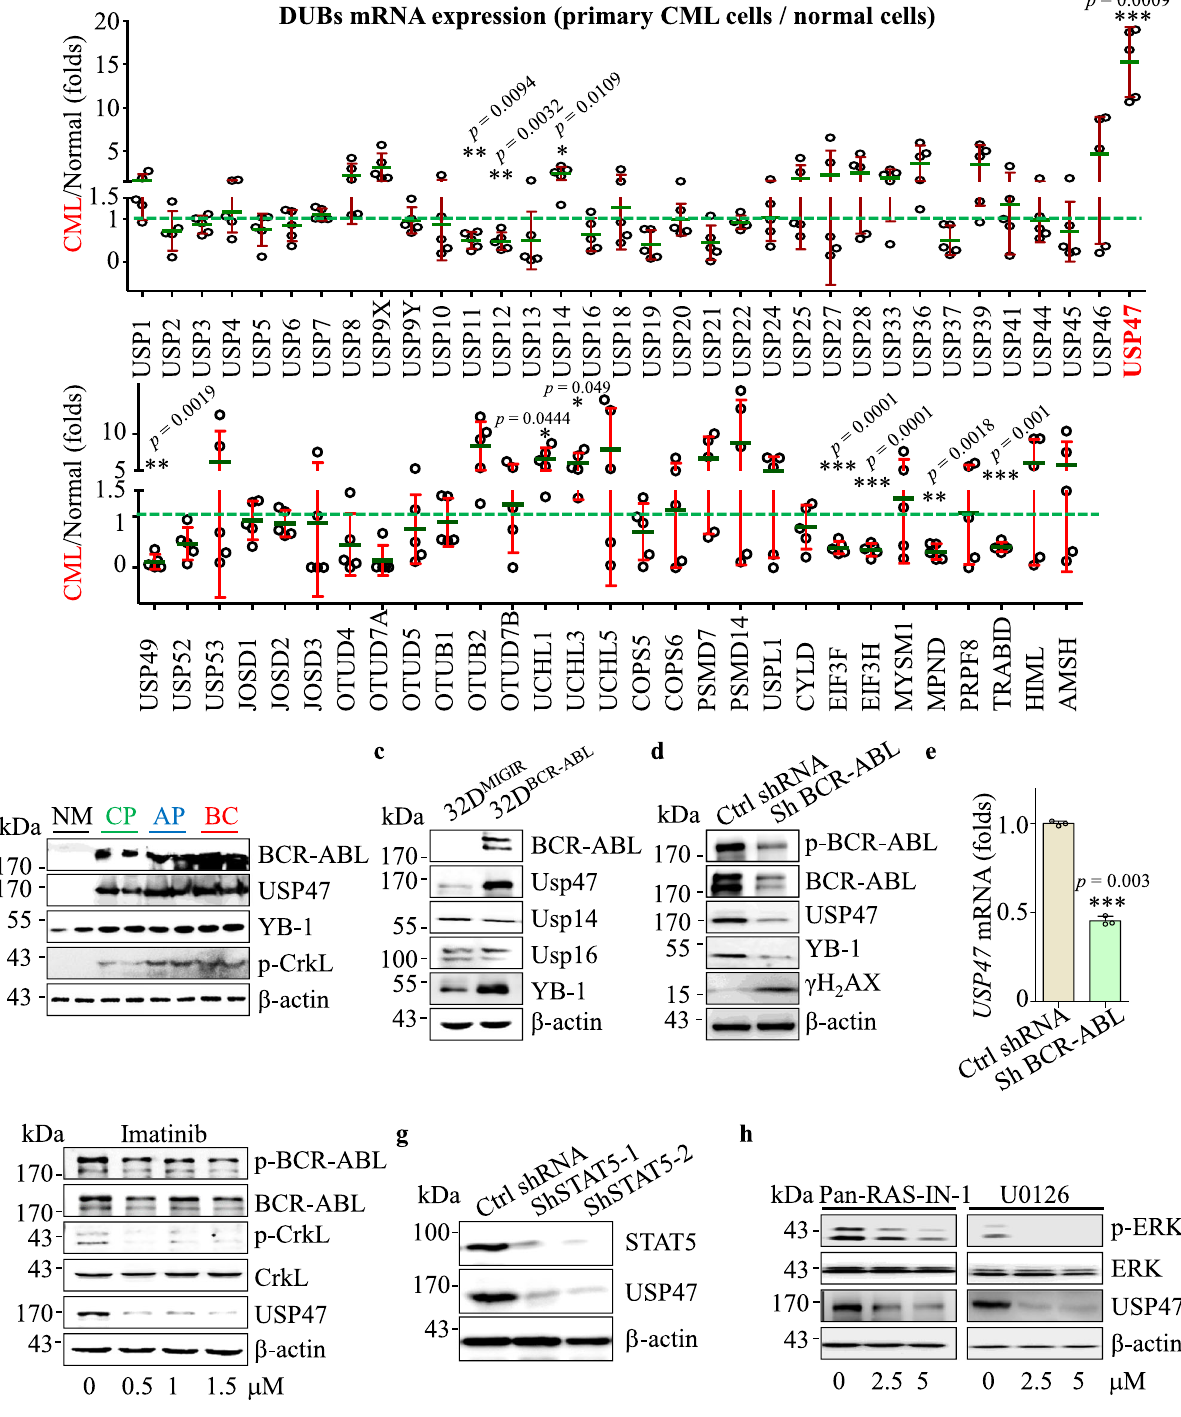
Fig. 1 BCR-ABL regulates USP47 through RAS/ERK and STAT5 pathway in CML. a mRNA levels of DUBs in bone marrow (BM) mononuclear cells from primary CML patients compared with normal BM CD34 + cells (CML n = 5, normal n = 3 biologically independent samples). Data are presented as mean ± s.d. * p < 0.05; ** p < 0.01; *** p < 0.001, using two-sided Student ’ s t -test. b USP47 and BCR-ABL protein expression were measured by western blot in primary CML cells at different clinical stages compared with normal BM CD34 + cells. NM normal BM, CP chronic phase, AP accelerated phase, BC blast crisis. c 32D MIGIR and 32D BCR − ABL cells were collected, and the indicated proteins were examined by western blot. d , e Protein ( d ) and mRNA ( e ) levels of USP47 in BCR-ABL stably knocked down K562 cells (Sh BCR-ABL) and vector-transfected cells (Ctrl ShRNA) ( n = 3 biologically independent samples per group). Data are presented as mean ± s.d. *** p < 0.001, using two-sided Student ’ s t -test. f K562 cells were treated with IM for 24 h, and the indicated proteins were examined by western blot. g STAT5 knockdown decreased USP47 expression in the K562 cells. h Pan-RAS-IN-1 (RAS inhibitor) and U0126 (ERK inhibitor) decreased USP47 expression in the K562 cells after 24 h of treatment. Source data are provided as a Source Data fi le.